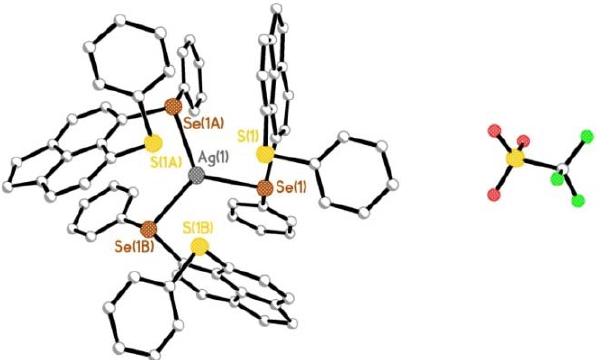
Figure 6. The three coordinate, mononuclear silver(I) complex 4 (H atoms omitted for clarity). The structure of 5 (adopting a similar conformation to 4 ) is omitted here but can be found in Figure S3 in the